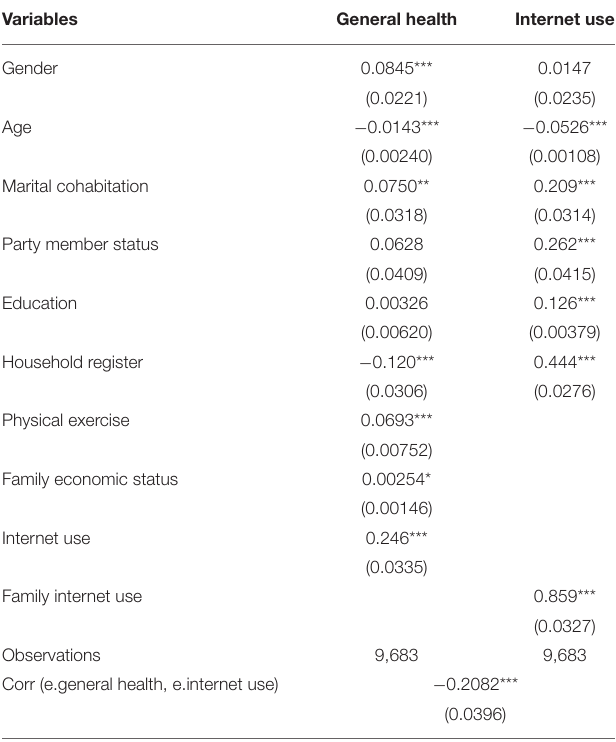
TABLE 4 | Results of endogenous